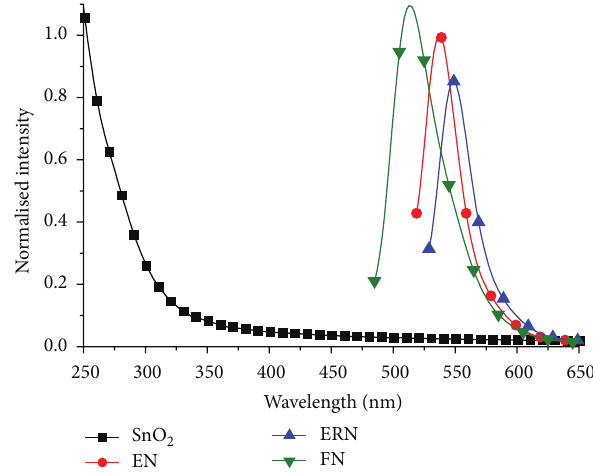
Figure 9: Combined absorption spectrum of colloidal SnO 2 (black) and emission spectra of dyes (green: FN, red: EN, and blue: